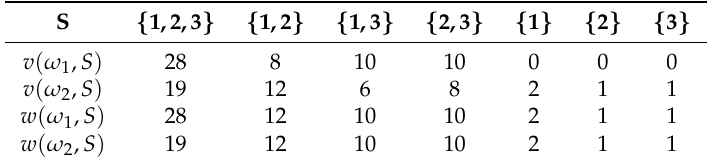
Table 1. Values of characteristic function v and approximated characteristic function w for states ω 1 and ω 2